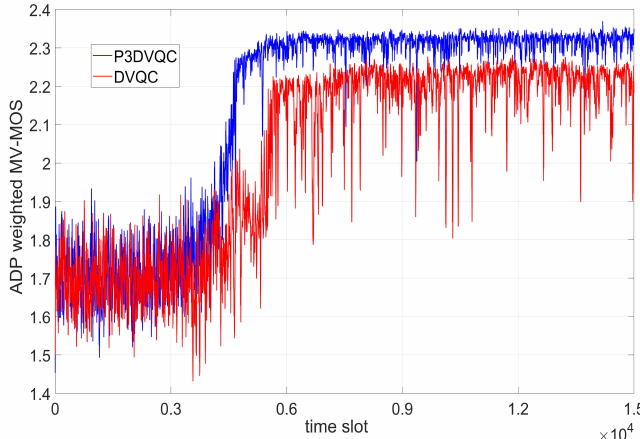
Figure 4. A comparison of P3DVQC and DVQC.